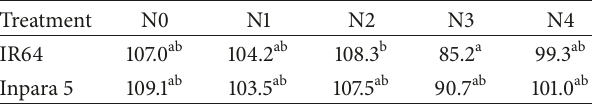
Table 3: Plant height (cm) at 42 days after planting of two rice varieties and fertilizing treatment at condition of dirty water submergence stress.